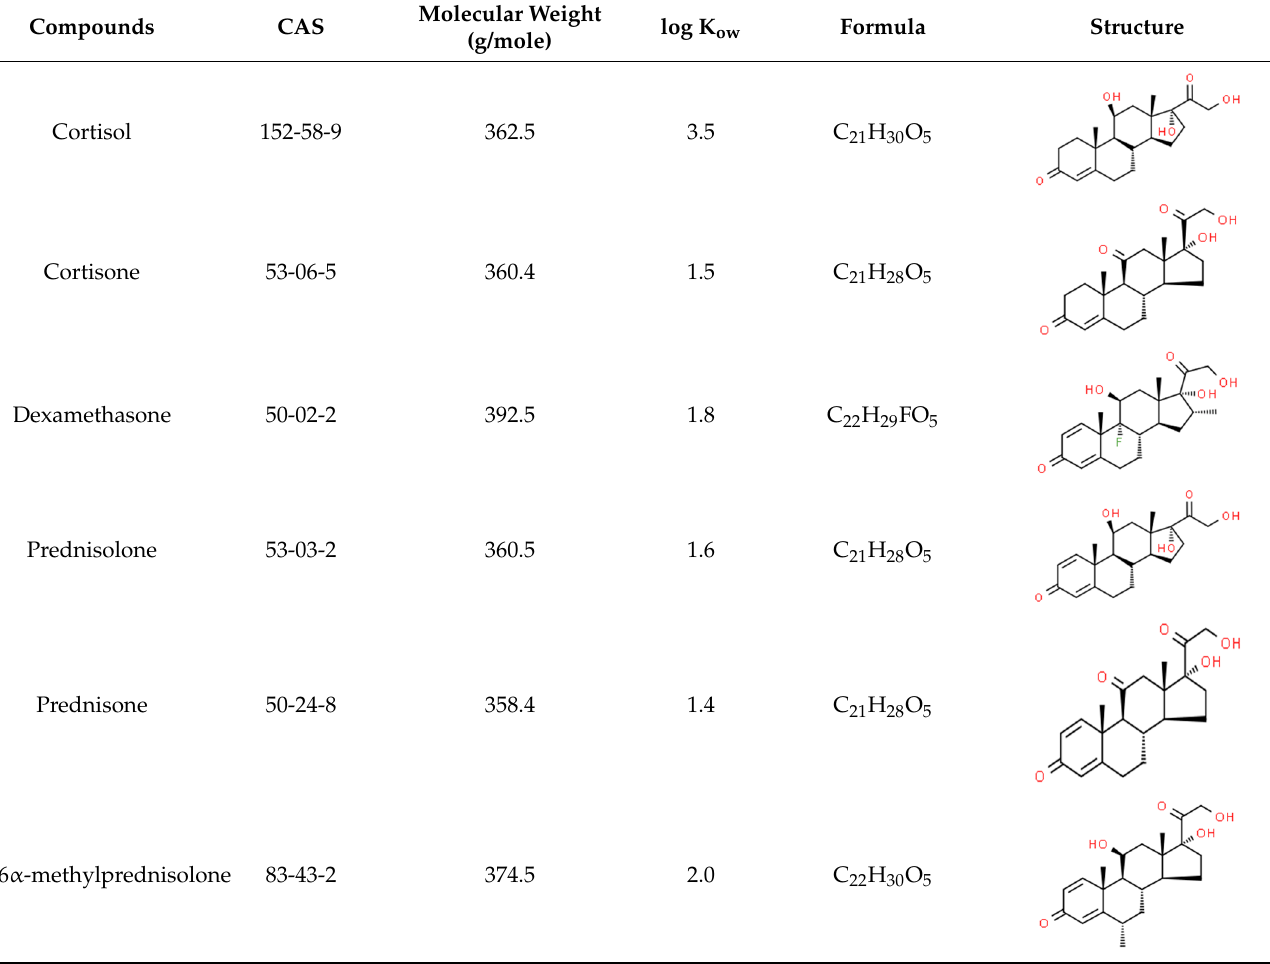
Table 1. Properties of six frequently found glucocorticoids (GCs) in water. Compounds